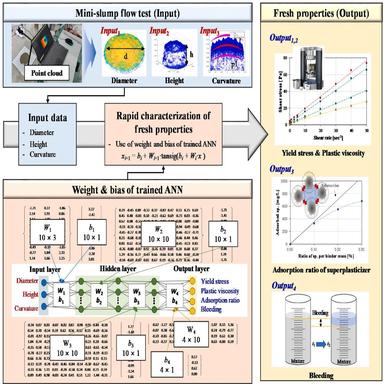
Proposed method for a rapid characterization of fresh properties of cementitious materials using point cloud analysis.